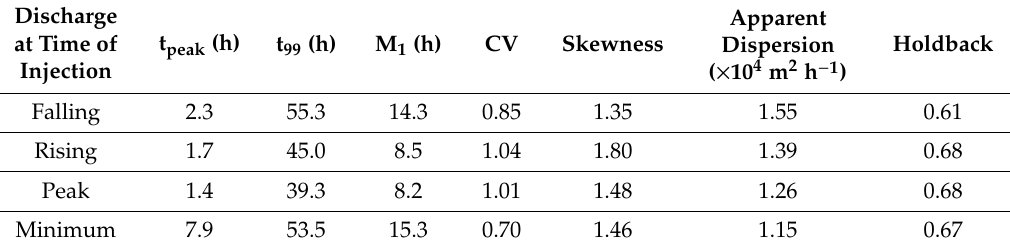
Table 2. Summary metrics for Uranine mass flux time series.